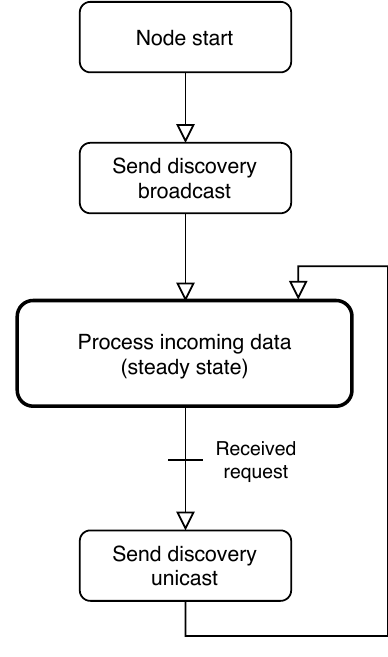
Figure 9. State machine of the sink node (root) under